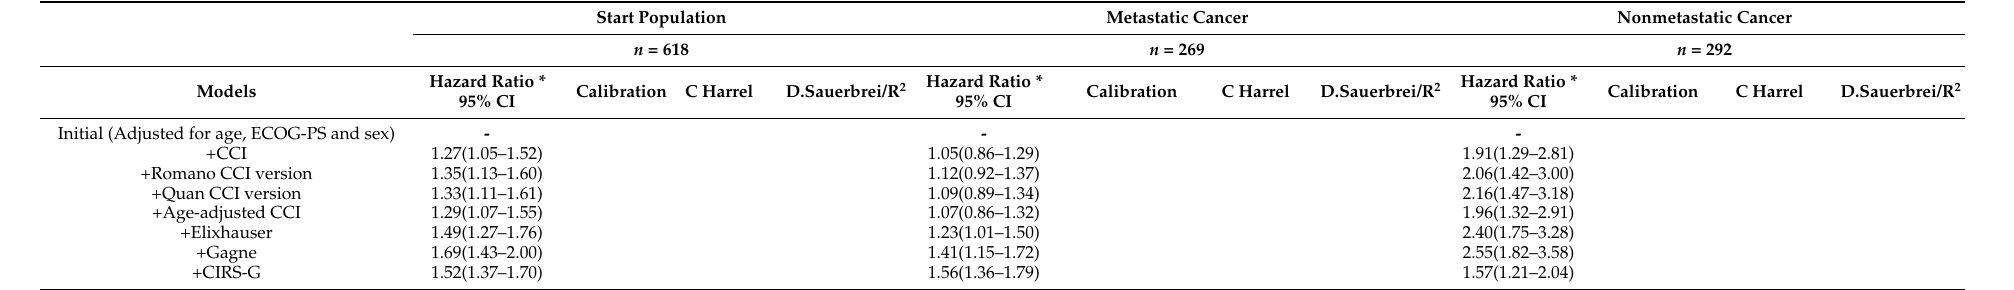
Table 4. The association of each comorbidity index with one-year mortality for the whole study population, metastatic and nonmetastatic cancer after the imputation of missing data.